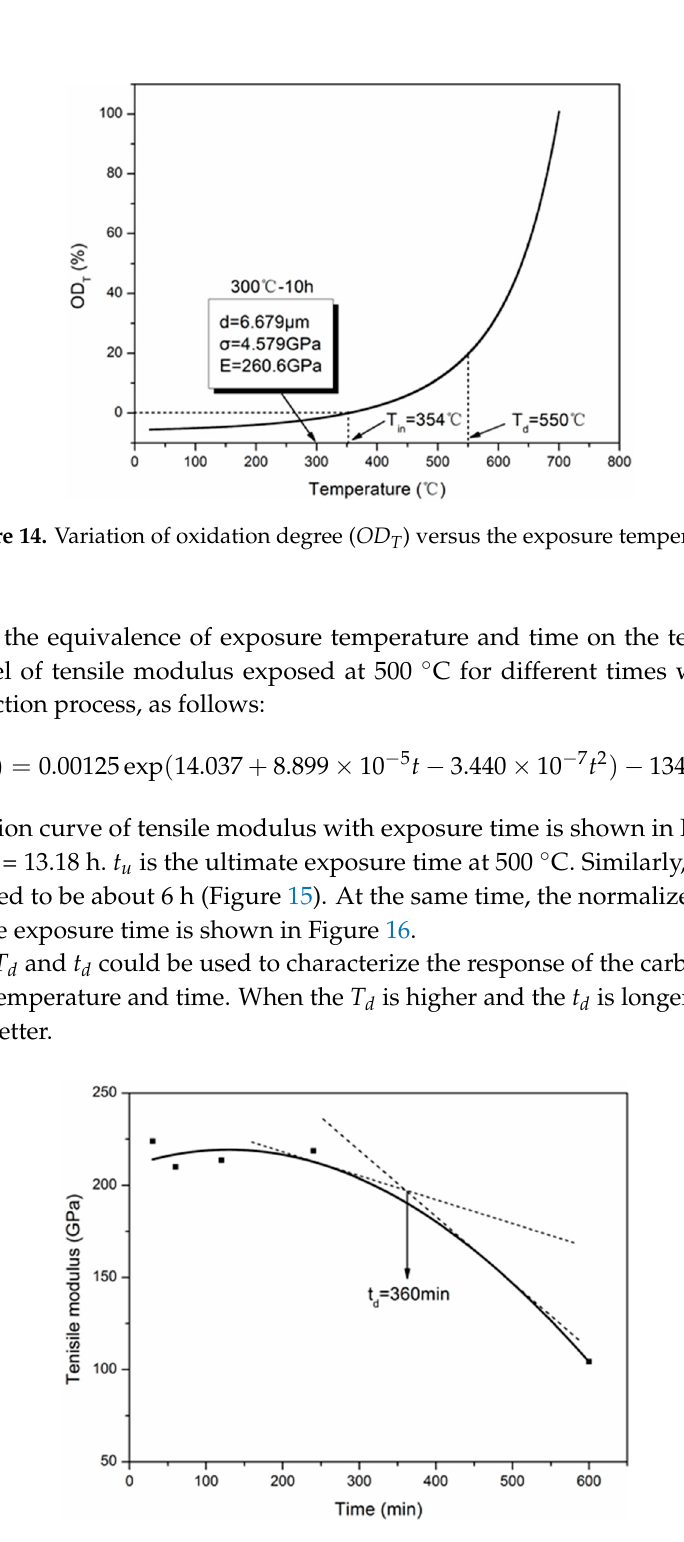
Figure 16. Variation of oxidation degree ( OD t ) versus the exposure time . 4.5.1.3. Time–Temperature Equivalence After obtaining the degradation model of tensile modulus exposed for different temperatures and times, the time–temperature equivalence of tensile modulus on cross-section distribution was studied. Figure 17 shows the variation curves of tensile modulus with the square of the diameter exposed to different temperatures and times. Obviously, the two curves had three intersection points, which were A ( d 2 = 0.0 μ m 2 ), C ( d 2 = 26.3 μ m 2 ), and D ( d 2 = 48.5 μ m 2 ), respectively. Furthermore, the effect of exposure temperature and time on tensile modulus could be characterized through the areas A ACDB-T and A ANCMDB-t surrounded by the two curves and two straight lines ( E = 0 GPa and d 2 = 48.5 μ m 2 ). Based on these areas, the time–temperature equivalence can be discussed quantitatively, as follows: